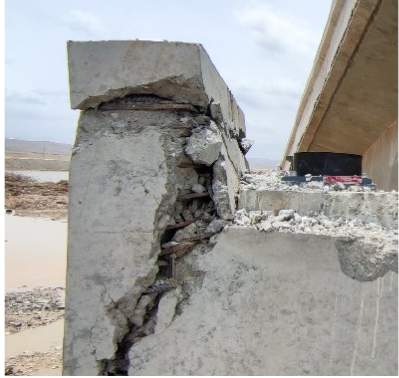
Figure 10. Seismic damage of blocks.